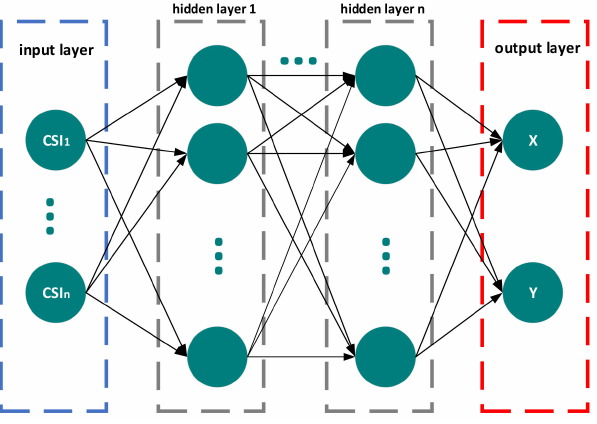
Figure 5. ANN network